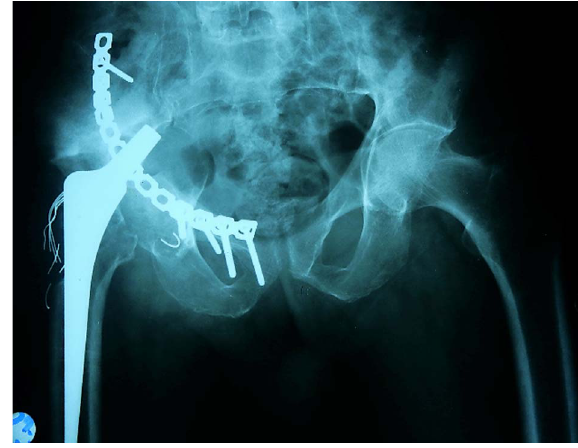
Figure 5. Intra-operative X-ray, the cup liner construct and the femoral head had been removed. Plating of the anterior column was done.